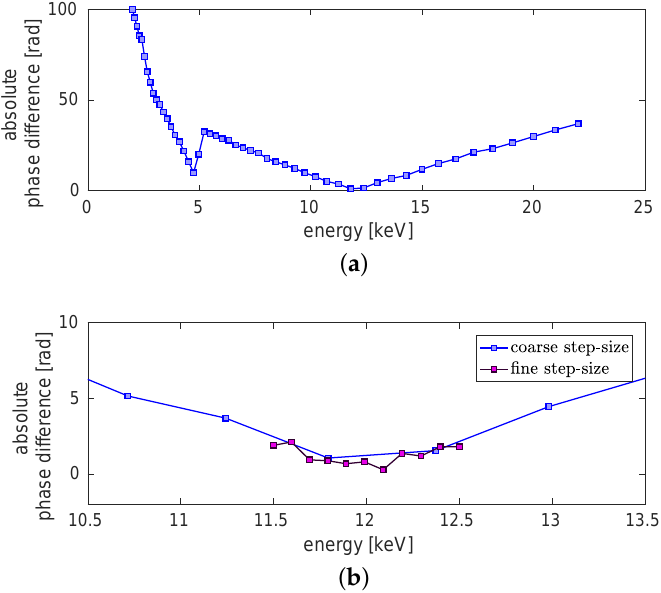
Figure 4. Evaluation of the dominant energy. ( a ) Absolute phase difference between theoretical phase and retrieved mean phase in dependence of the energy. The calculated energy range is between 2keV and 22keV. ( b ) Detailed view on the minimum with a finer step-size (purple). For the finer step-size the evaluated energy range is between 11.5keV and 12.5keV. In blue a section of the plot shown in ( a ) can be seen. The error is in the regime of